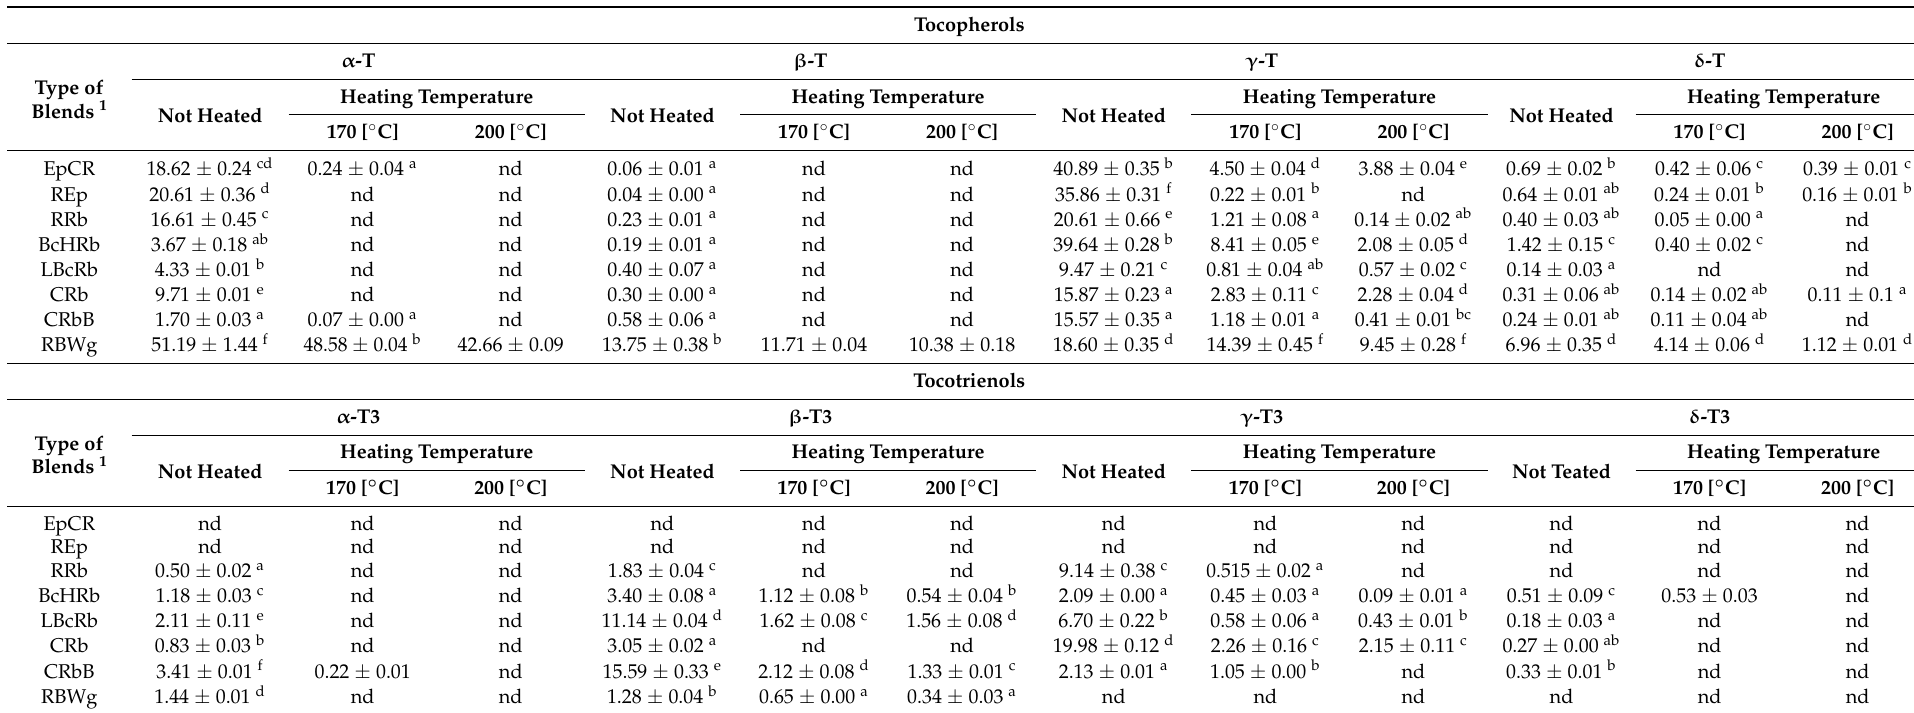
Table 3. Changes of tocochromanol contents [mg/100 g of oil] during heating oil